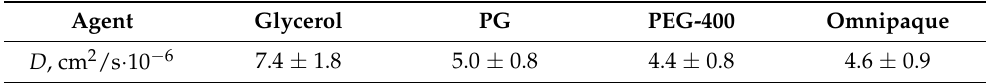
Table 2. Effective diffusion coefficients obtained from the kinetic curves given in Figure 1. D values characterize the rate of optical clearing of cartilaginous samples during immersion in the correspond- ing solutions. The concentration of each solution is 30% ( v / v